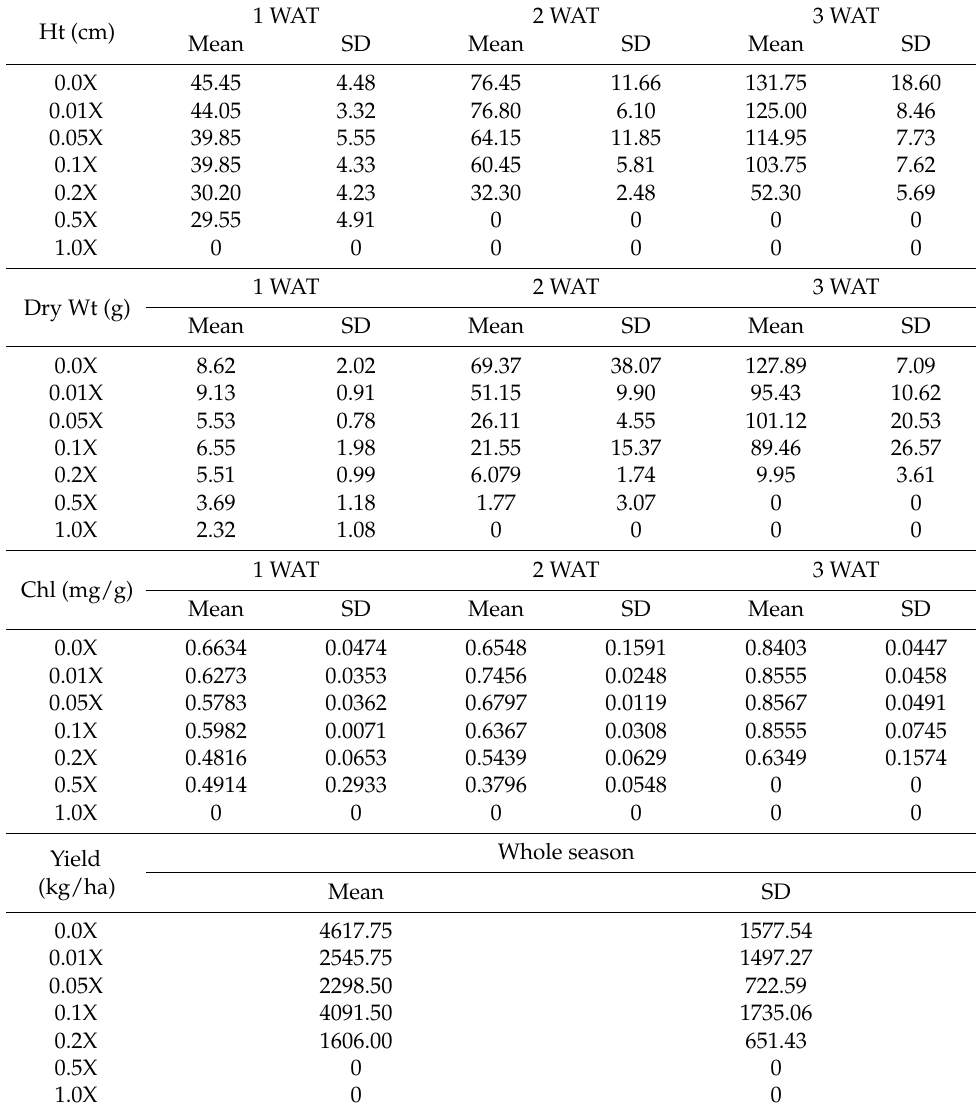
Table 1. Statistics of the biological responses of corn plants (X = 0.866 kilograms acid equiva- lents/hectare (kg ae/ha) is the recommended application amount per